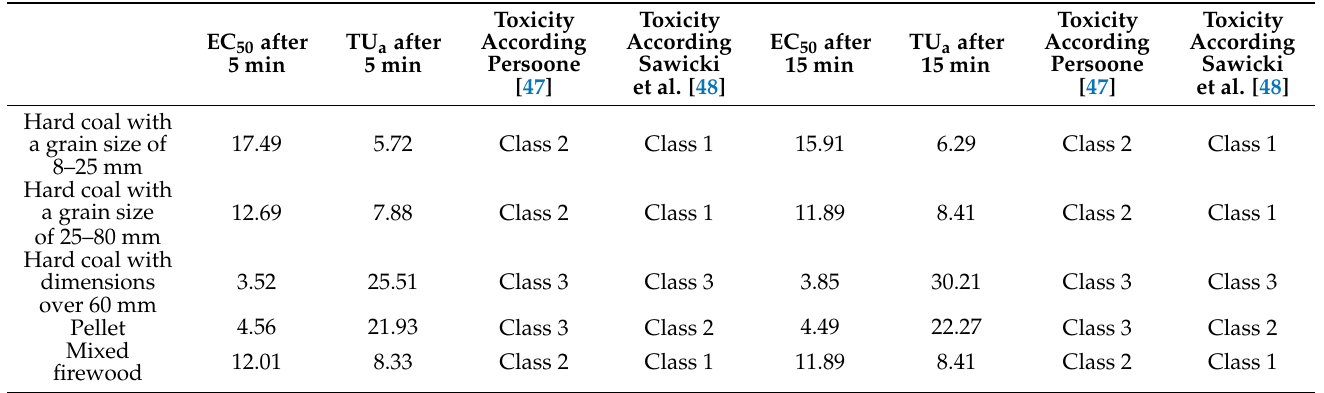
Table 3. Acute toxicity of extracts obtained from the combustion of tested